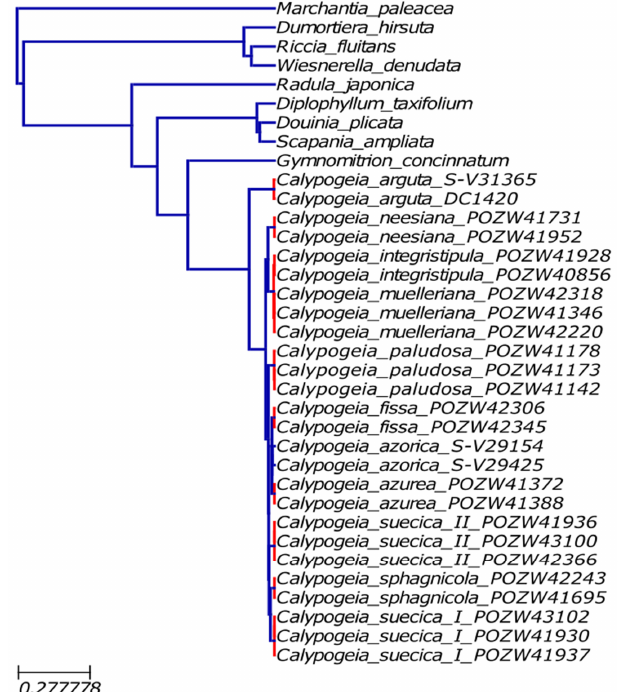
Figure 3. Species delimitation by GMYC analysis. Red lines indicate the same species group. Quite similar results were revealed by ASAP (distance-based method) for mitogenome data (Figure 4A). The lowest asap-score at the level of 4.5 had three partitions. One of them showed more species than was expected, because it treated specimens of C. azorica as two species. On the other hand, another partition was less sensitive and pointed out two species fusions. The third partition merged only C. muelleriana with C. integristipula together, but the dendrogram supporting the bar chart indicated that this fusion is dubious. The orange dot on the node between specimens of C. muelleriana and C. integristipula suggests that such a merger is rather unlikely, and these individuals correspond to two different species. The correctness of the above division is supported by the ASAP analysis based on chloroplast genomes (Figure 4B). The node between C. muelleriana and C. integristipula is marked with a black dot, which denotes an even lower probability than for mitogenomic data, that these specimens belong to one group. Two partitions with the lowest asap-score values (1.5 and 3.0) generated for chloroplast genomes perfectly distinguished 11 species of Calypogeia .